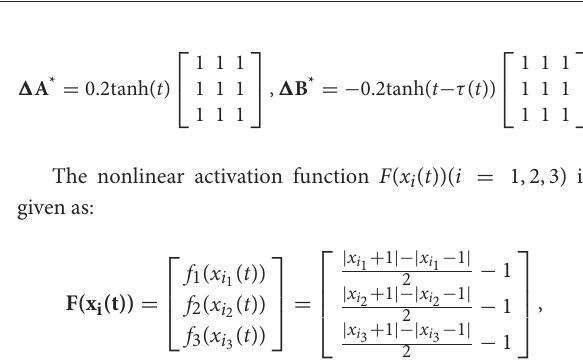
1. (D) The anti-synchronization errors = −